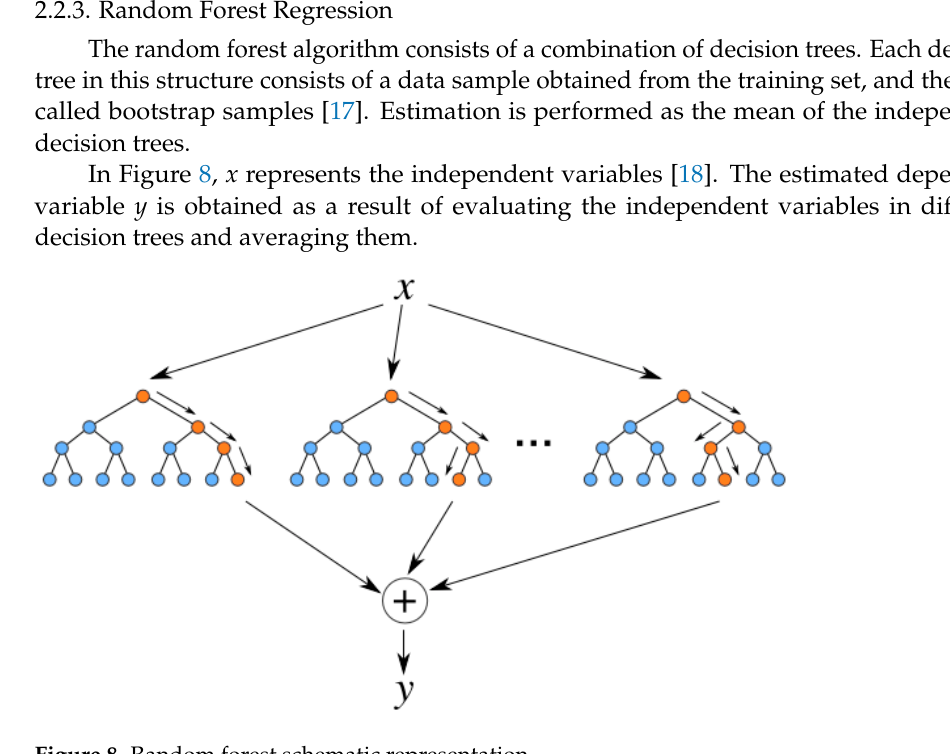
Figure 8. Random forest schematic